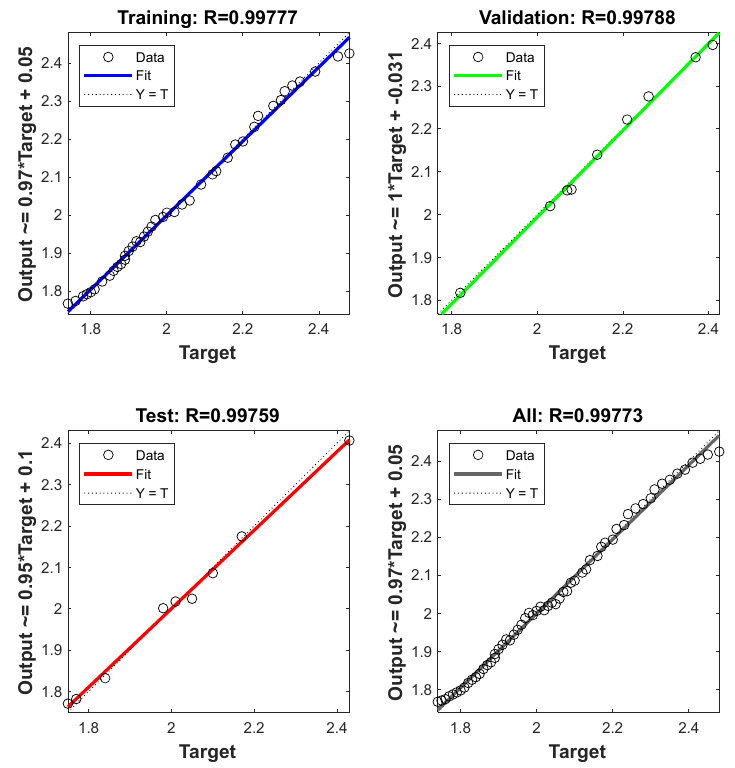
Figure 11. ANN Method Relationship between real data and predicted values for Consumption Energy.